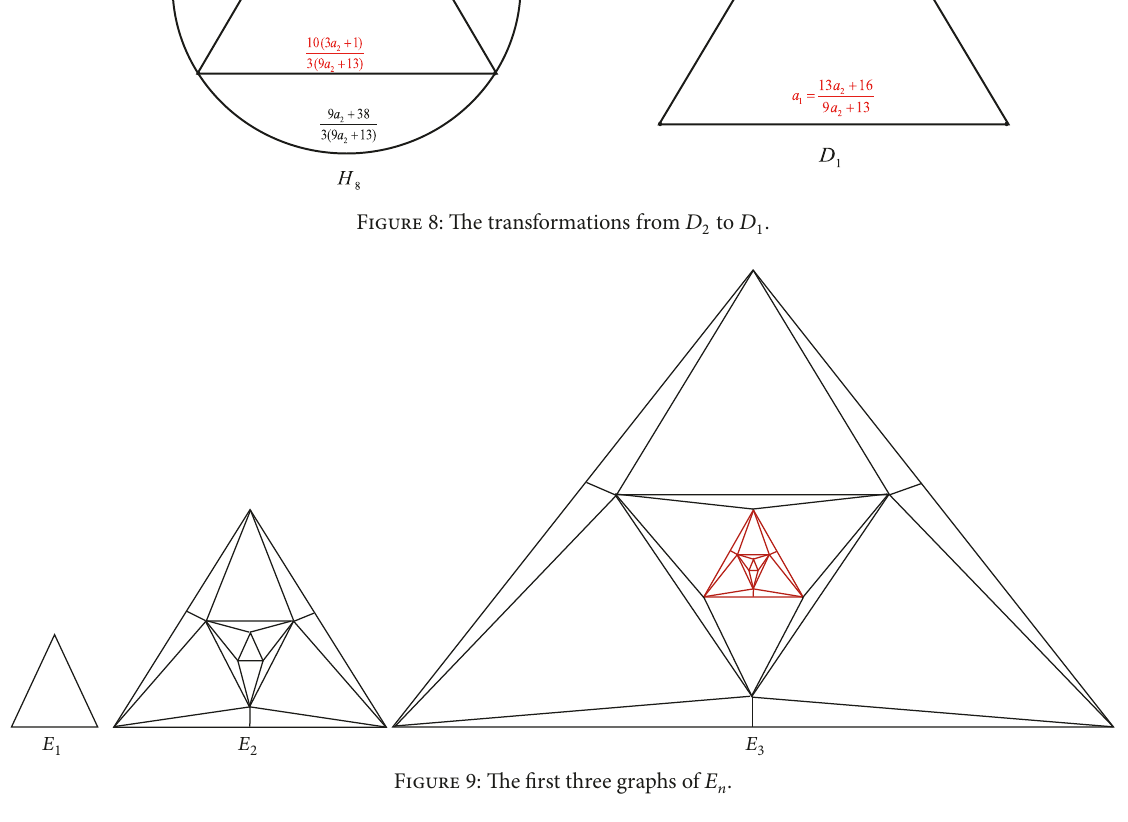
Figure 9: The first three graphs of 𝐸 𝑛